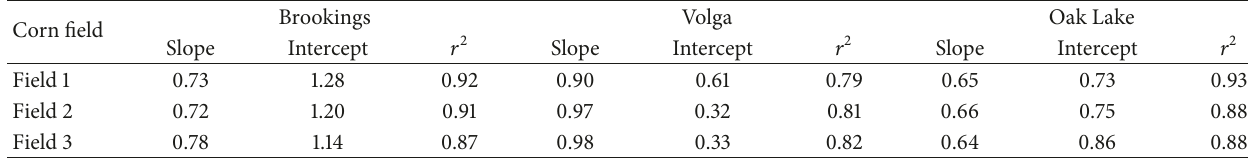
-METRIC values and ET a